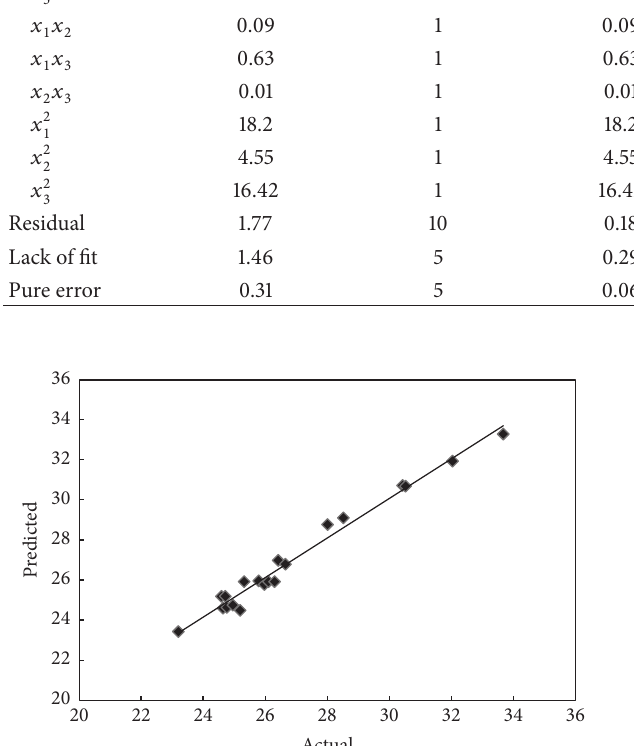
Figure 2: Predicted versus actual values for adsorption capacity of OPEFB